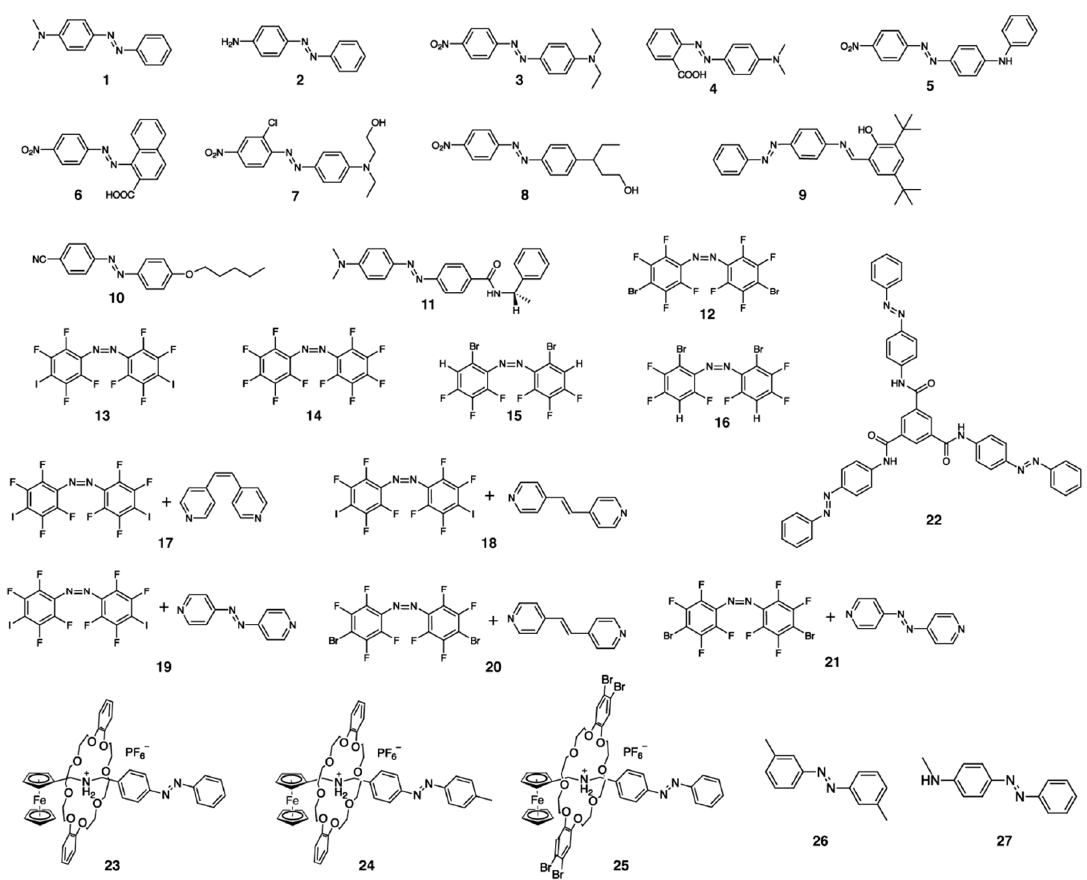
Figure 1. Photomechanical azobenzene crystals previously reported in [26] for 1 , [27] for 2 , [29] for 3 – 7 , [32] for 8 , [33] for 9 , [49] for 10 , [38] for 11 , [42,43] for 12 – 16 , [44] for 17 – 21 , [53] for 22 , [45] for 23 – 25 , [46] for 26 , and [47] for 27 .